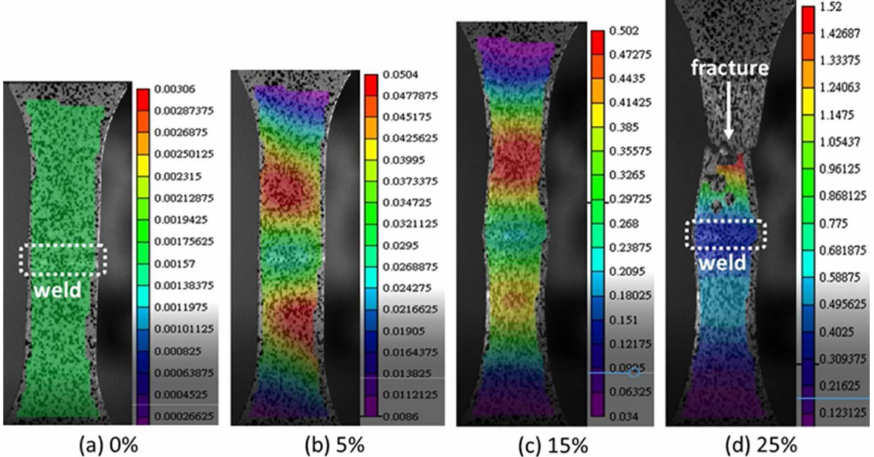
Figure 9. Images from the digital image correlation (DIC) of CP Ti, 200 µ m, 100 W, and 30 mm/s during tensile testing showing sample conditions at various percentages of strain ( a ) at 0%, ( b ) 5%, ( c ) 15%, and ( d ) 25%, which correspond to fracture. Note: the numbers associated with the images are local strains ×